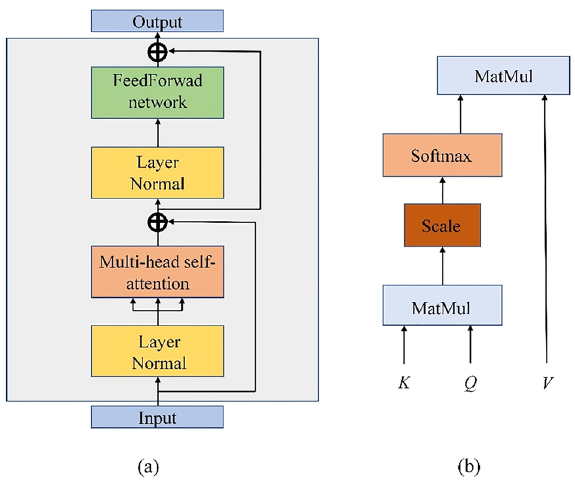
Figure 7. Structure of the Transformer encoder block and the illustration of the self-attention mechanism. ( a ) Transformer encoder block. ( b ) self-attention